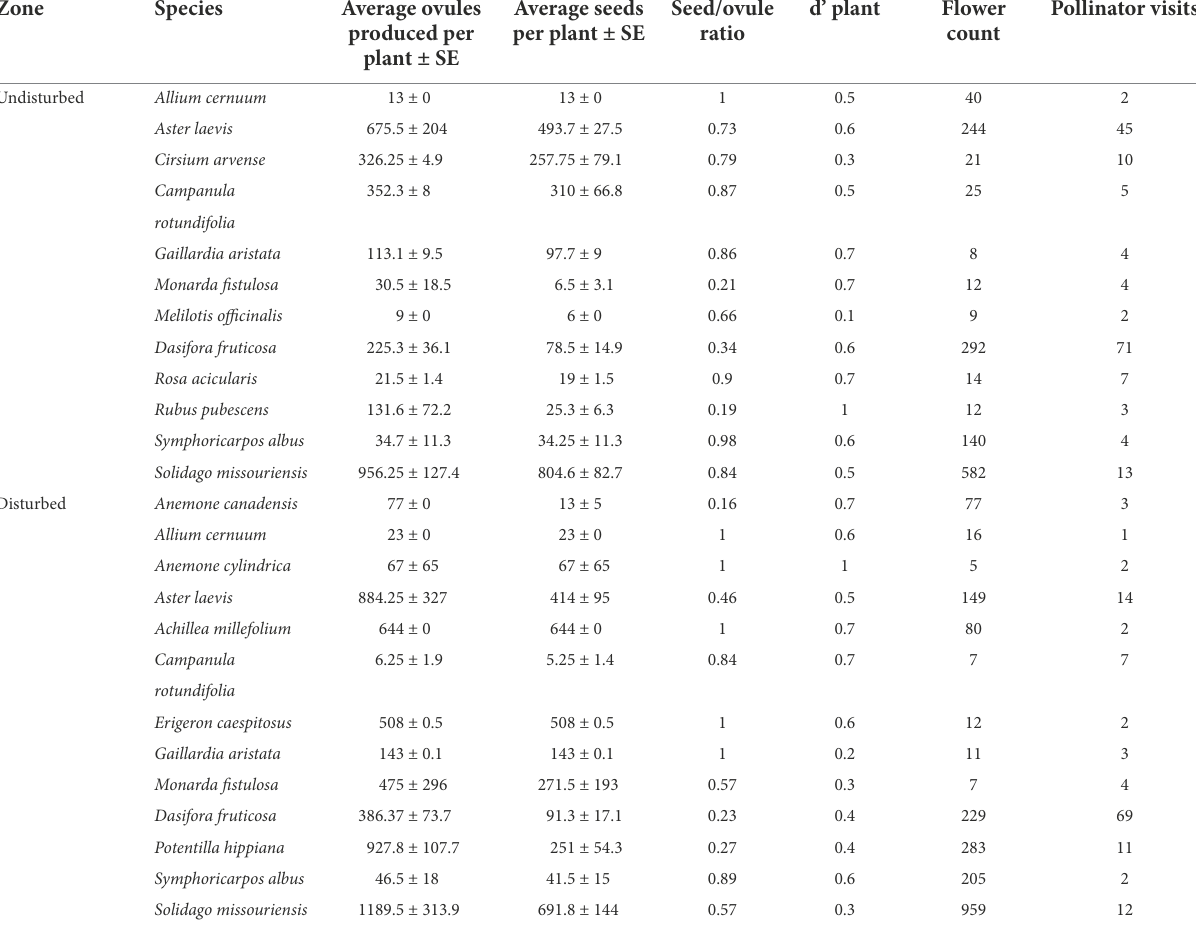
TABLE 1 Seed set production for 25 species recorded in undisturbed and disturbed zones in Glenbow Ranch Park. Zone Species